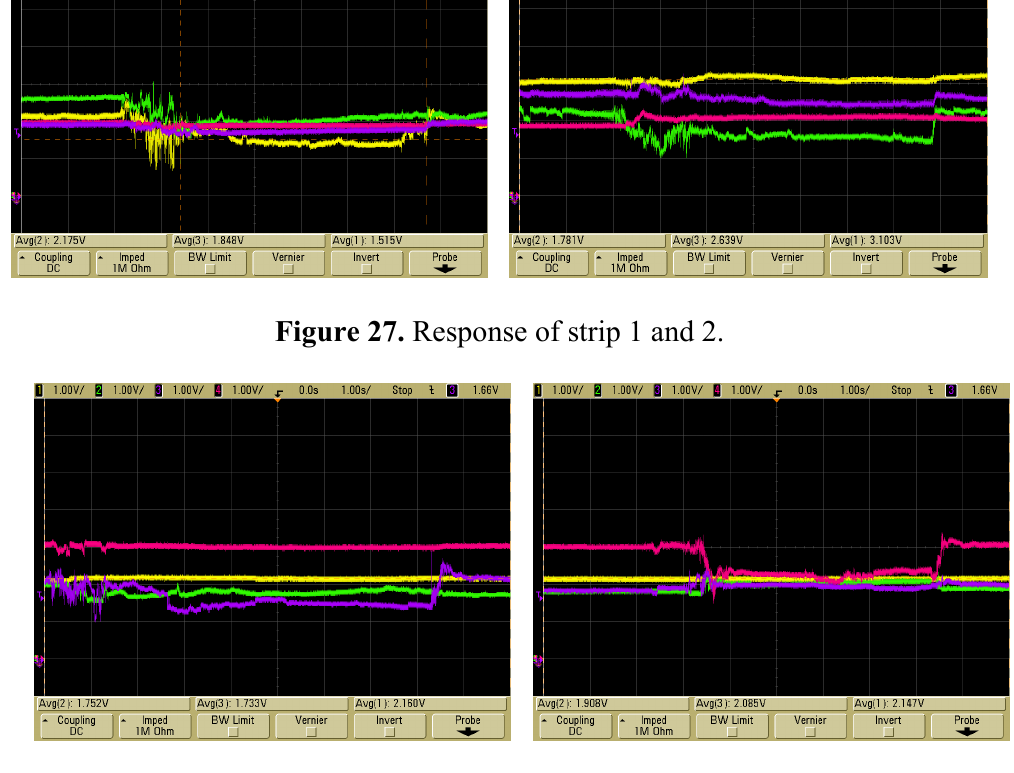
Figure 28. Response of strip 3 and